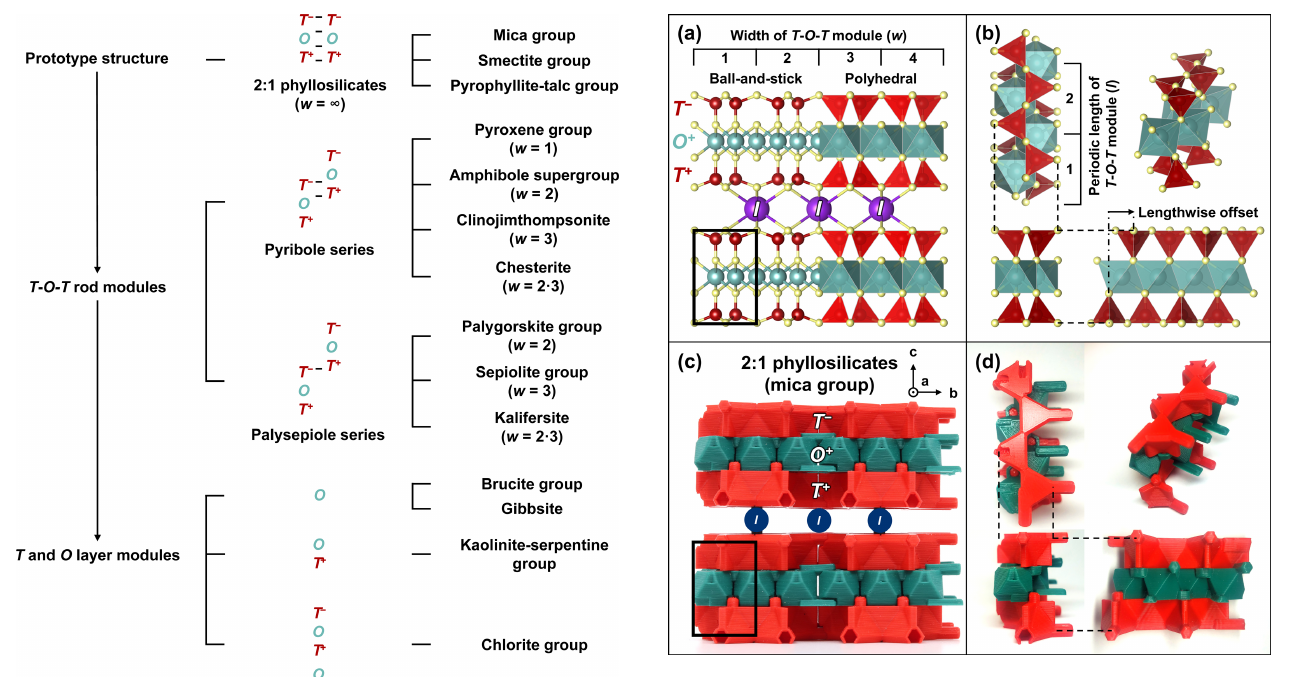
Figure 4. Modeling of TotBlocks after the 2:1 phyllosilicate pro- totype structure. (a) Ball-and-stick and polyhedral representations of the crystal structure of the mica group (Hendricks and Jeffer- son, 1939) using VESTA (Momma and Izumi, 2011). The black rectangle represents the location for a single-chain-width ( w = 1) T - O - T rod module that is extracted in (b) . (b) Extraction of the single-width T - O - T rod module (polyhedral representation), dis- played as orthographic projections. (c) Equivalent structure of the 2:1 phyllosilicates using TotBlocks (black pegs are structural sup- ports intended to hold individual layers; the positions for missing interlayer sites I are labelled circles). (d) Equivalent single-chain- width ( w = 1) T - O - T rod module using TotBlocks, displayed as orthographic